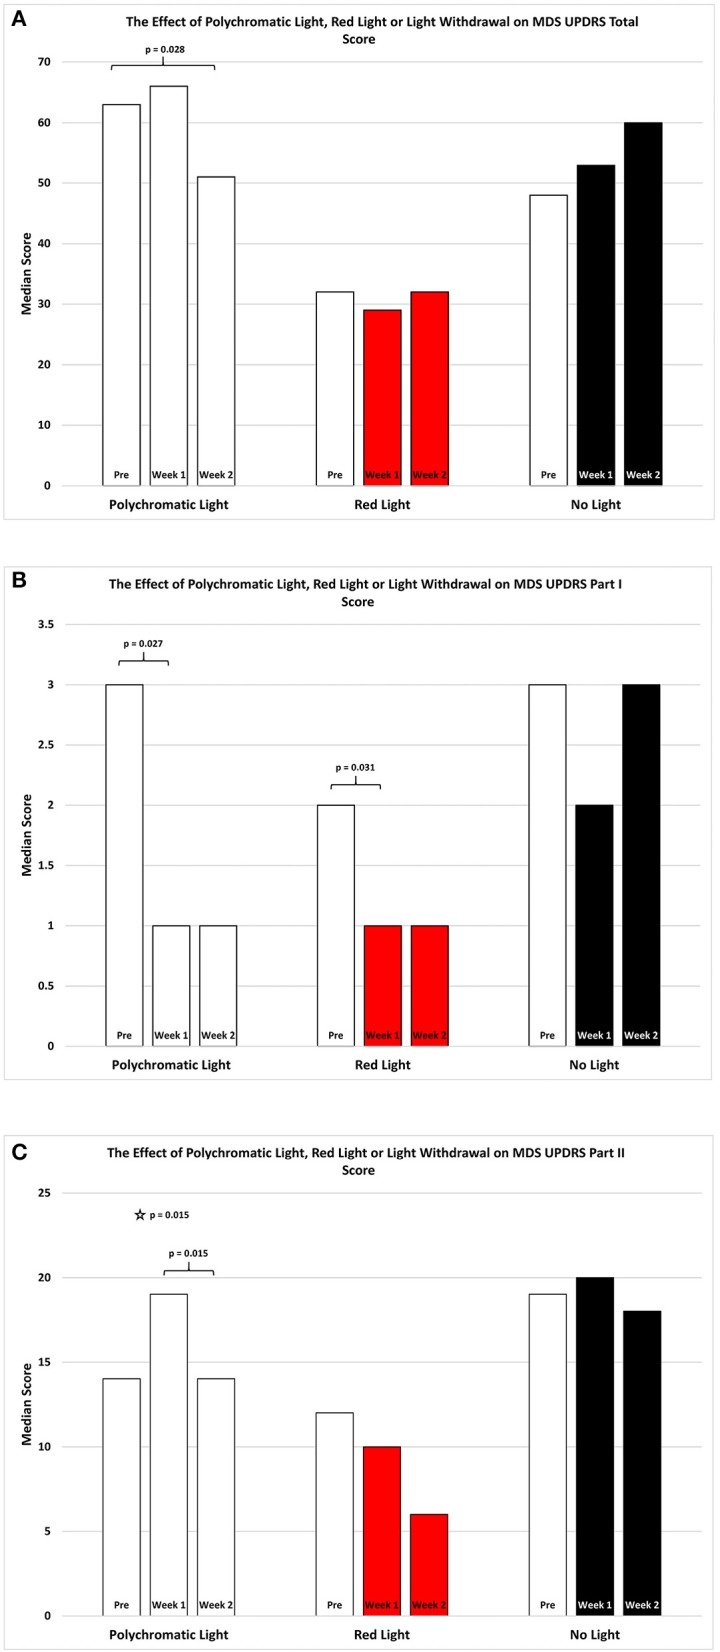
The effect of continued daily exposure to polychromatic light, red light or withdrawal of polychromatic light on M.D.S.U.P.D.R.S. scores in patients treated previously with BT. Performance on the Total Score (A), Part I (B) and Part II (C) is expressed as the median score for each group after 3 assessments over a 2 week period. The pre-score served as the baseline and was obtained when the study commenced and before patients were randomly assigned to their respective treatment groups. The inclusion bars show significant statistical comparisons with p-values indicating the levels of significance obtained. Statistical comparisons were made between baseline (Pre) and Week 1, Pre and Week 2 and Week 1 and Week 2. Significant levels were determined a priori with a significant effect defined as p ≤ 0.05 while trends were designated as p-values ranging from 0.051 to 0.099. The star represents a significant overall effect using the Friedman's Two Way ANOVA while the inclusion bars mark significant comparisons using the Wilcoxon Signed Rank Test.